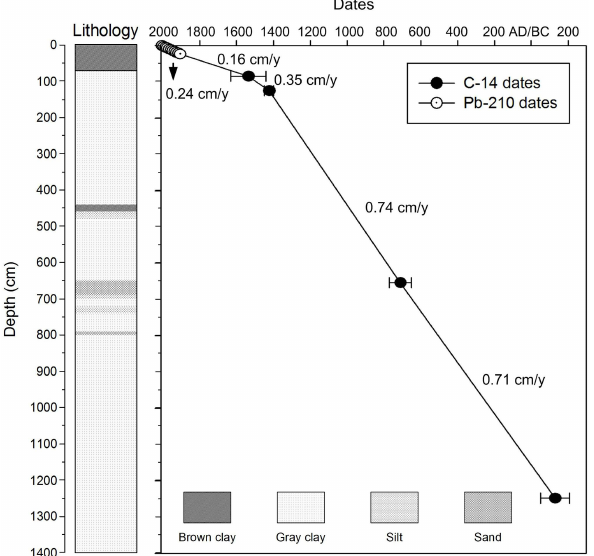
Figure 3. Lithology and age-depth profile of the studied sediment core from DHL with dates and estimated sedimentation rates. samples taken from the upper 25 cm of the core were ana- lyzed for 210 Po by α -spectrometry, with 209 Po added as the yield determinant. More detailed procedures can be found in Huh and Su (2004). According to the age model, the upper 1100 cm of the core represented the records for the period of AD 100 to